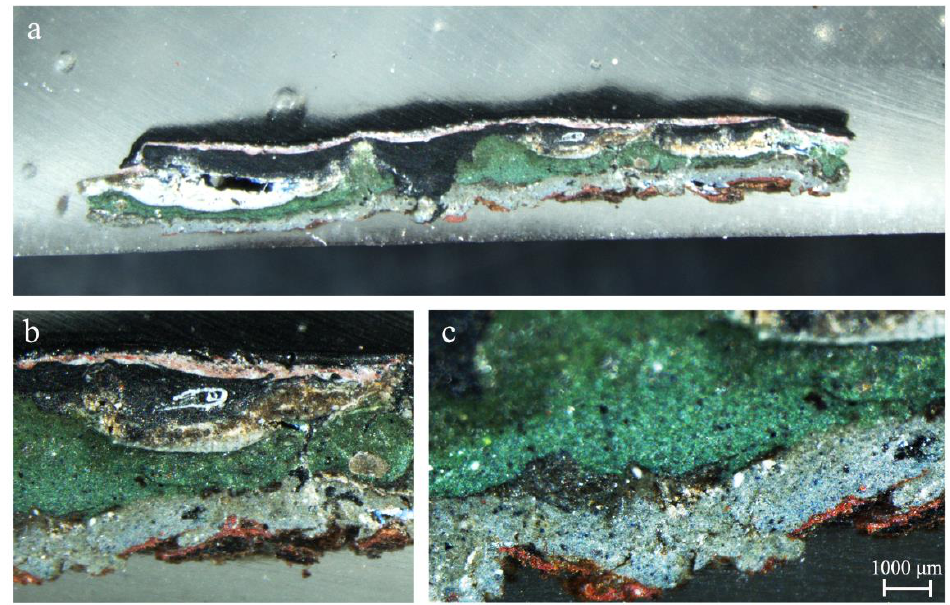
Figure 4. Cross-sections at diferent magnification ( a – c ) of the painting sample SUBS-3b from a black area where the original paint layer is visible.